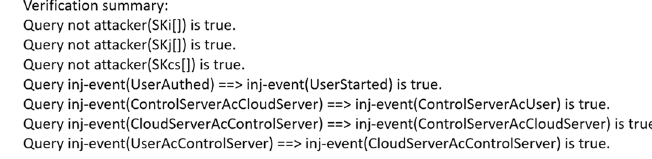
Fig. 6 Verification